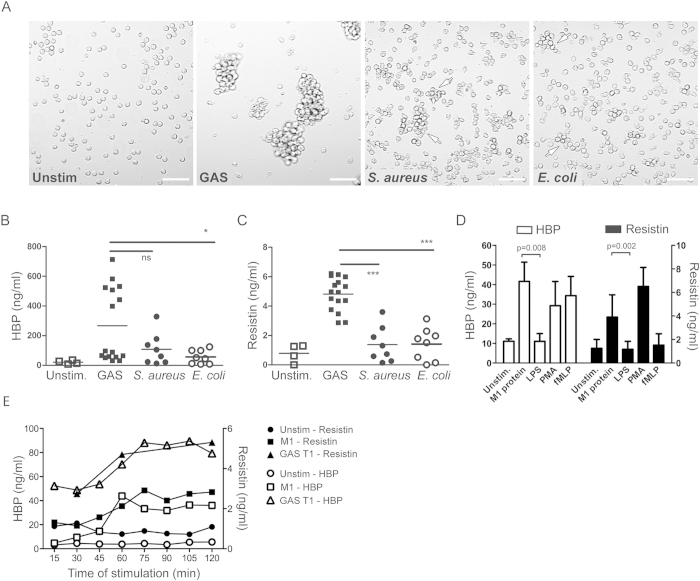
Release of HBP and resistin differs depending on bacterial stimuli.Primary neutrophils isolated from blood of healthy donors were stimulated for 2 hours with either fixed bacteria or different bacterial components. HBP and resistin levels were determined in cell culture supernatants by ELISA. (A) Microscopic bright field images of neutrophils stimulated with the indicated bacteria (20 cfu/cell). Arrows indicate aggregated neutrophils. The scale bars indicate 100 μm. (B,C) HBP and resistin levels in supernatants from cells stimulated with GAS (n = 4), S. aureus (n = 2) and E. coli (n = 2) (67 cfu/cell). The data show results from four experiments using different donors. Kruskal Wallis with Dunns test was used for comparison between groups. (D) HBP and resistin levels in supernatants of neutrophils stimulated with the streptococcal M1-protein (0.5 μg/ml), LPS (50 ng/ml), and the known neutrophil activators PMA (25 ng/ml) and fMLP (5 μg/ml). Mean ± SD of results from five separate experiments using cells from different donors. Mann-Whitney U test was used for comparison between and differences are shown in p values, *P < 0.05, ***P < 0.001. (E) Kinetics of HBP and resistin levels in supernatants of neutrophils stimulated with fixed GAS T1 strain (67 cfu/cell) or with streptococcal M1-protein (1 μg/ml) for 2 hours. The figure shows one representative experiment out of two performed.